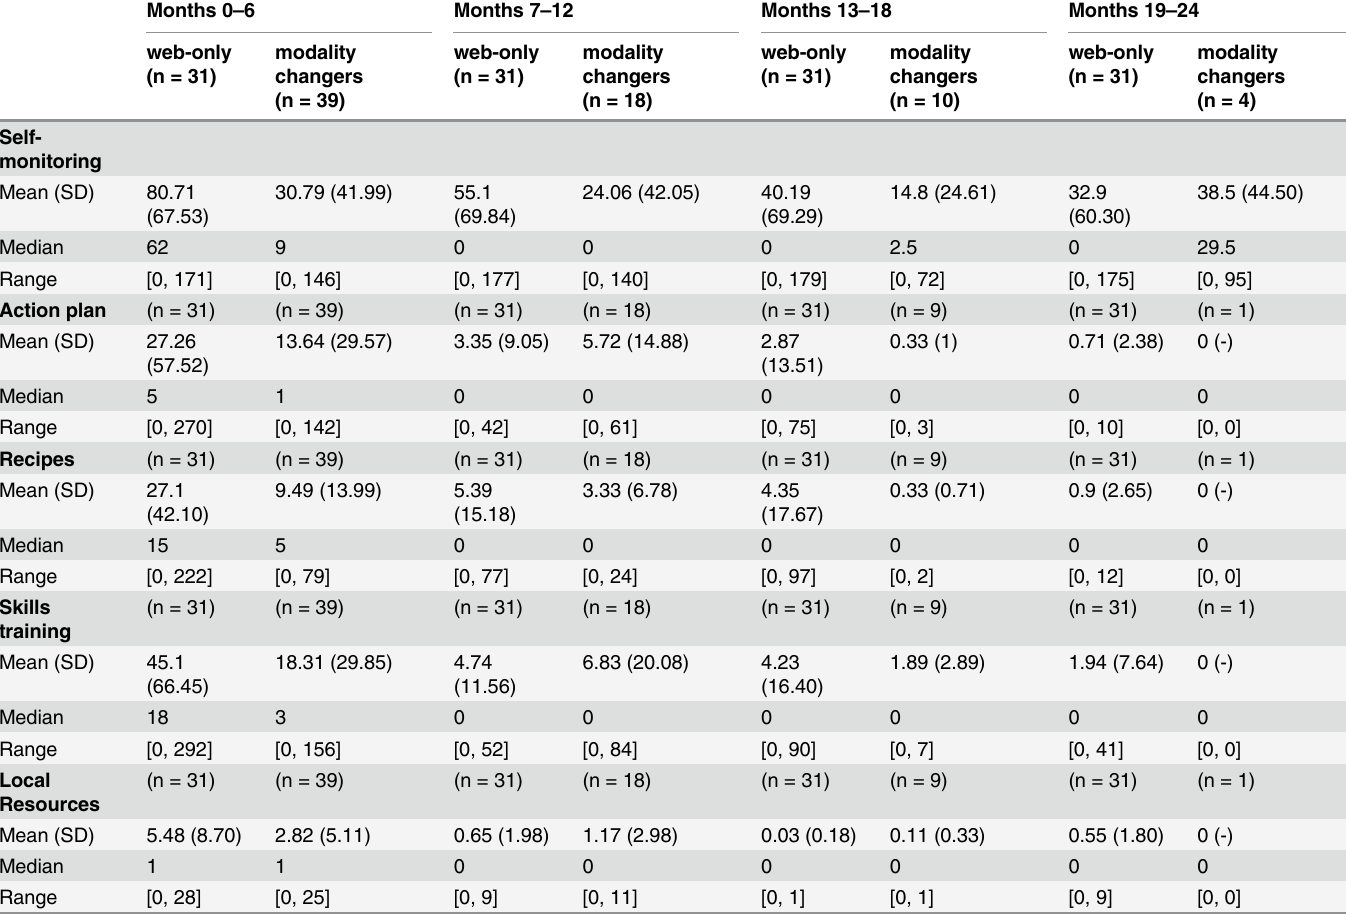
Table 2. Website use by 6 month period in web-only participants (n = 31) and participants who changed from web to IVR (n = 39) *